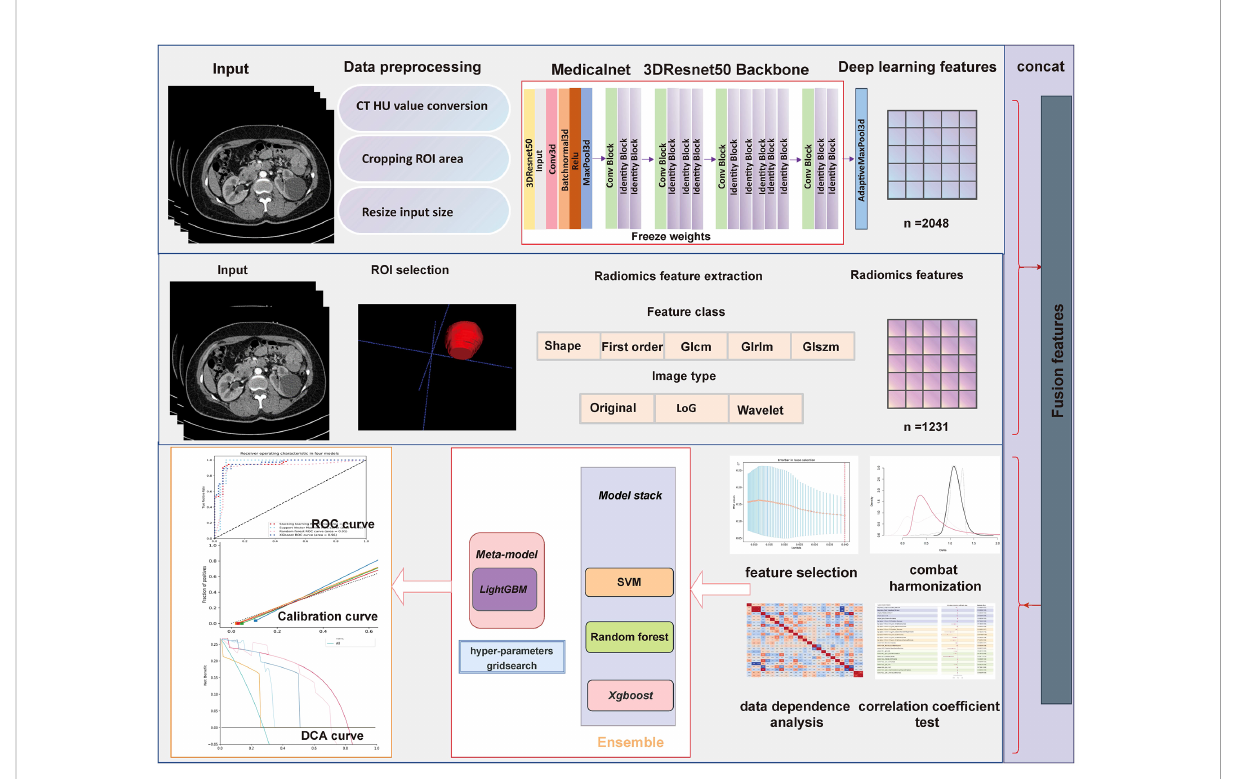
Table 2. In Figure 5, all four machine learning models illustrate good calibration